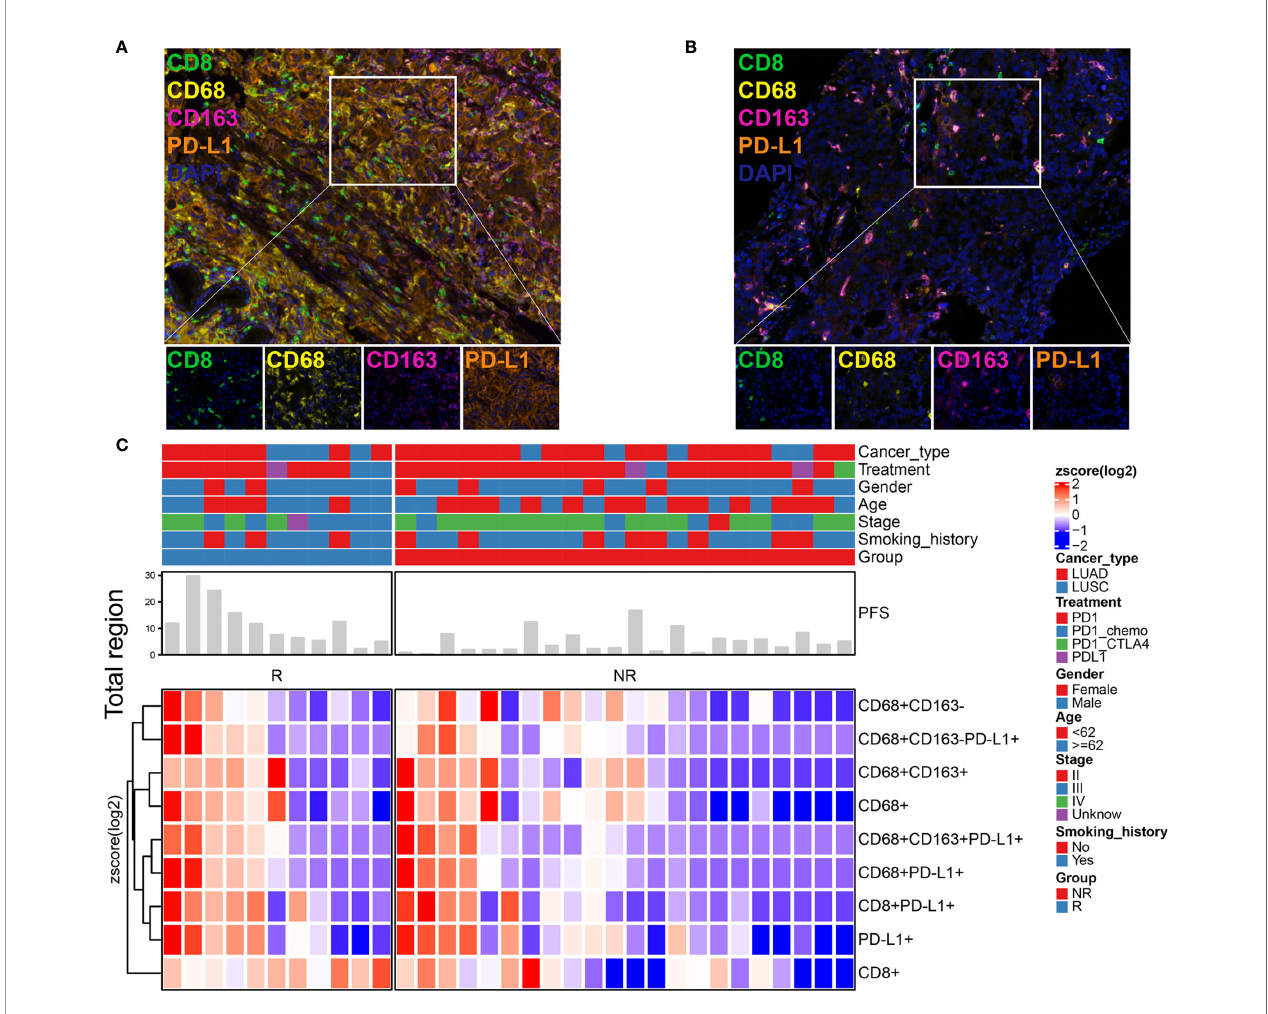
FIGURE 1 | Immune landscape of NSCLC patients treated with immune checkpoint inhibitor (ICI) therapy. Immune cell in fi ltration was detected using a multiplex immunohistochemistry (mIHC) platform (panel: CD8/CD68/CD163/PD-L1). The mIHC images represent the group that responded to immunotherapy (A) and the group that did not respond to immunotherapy (B) . Magni fi cation, 200×. The percentages of differentially expressed cells were log-transformed and z-score standardized. Heatmaps of immune cell in fi ltration in the total region (C) were plotted and clustered. They indicated that each patient had a different immune microenvironment, which may lead to different responses to and bene fi ts from immunotherapy. R, response; NR,